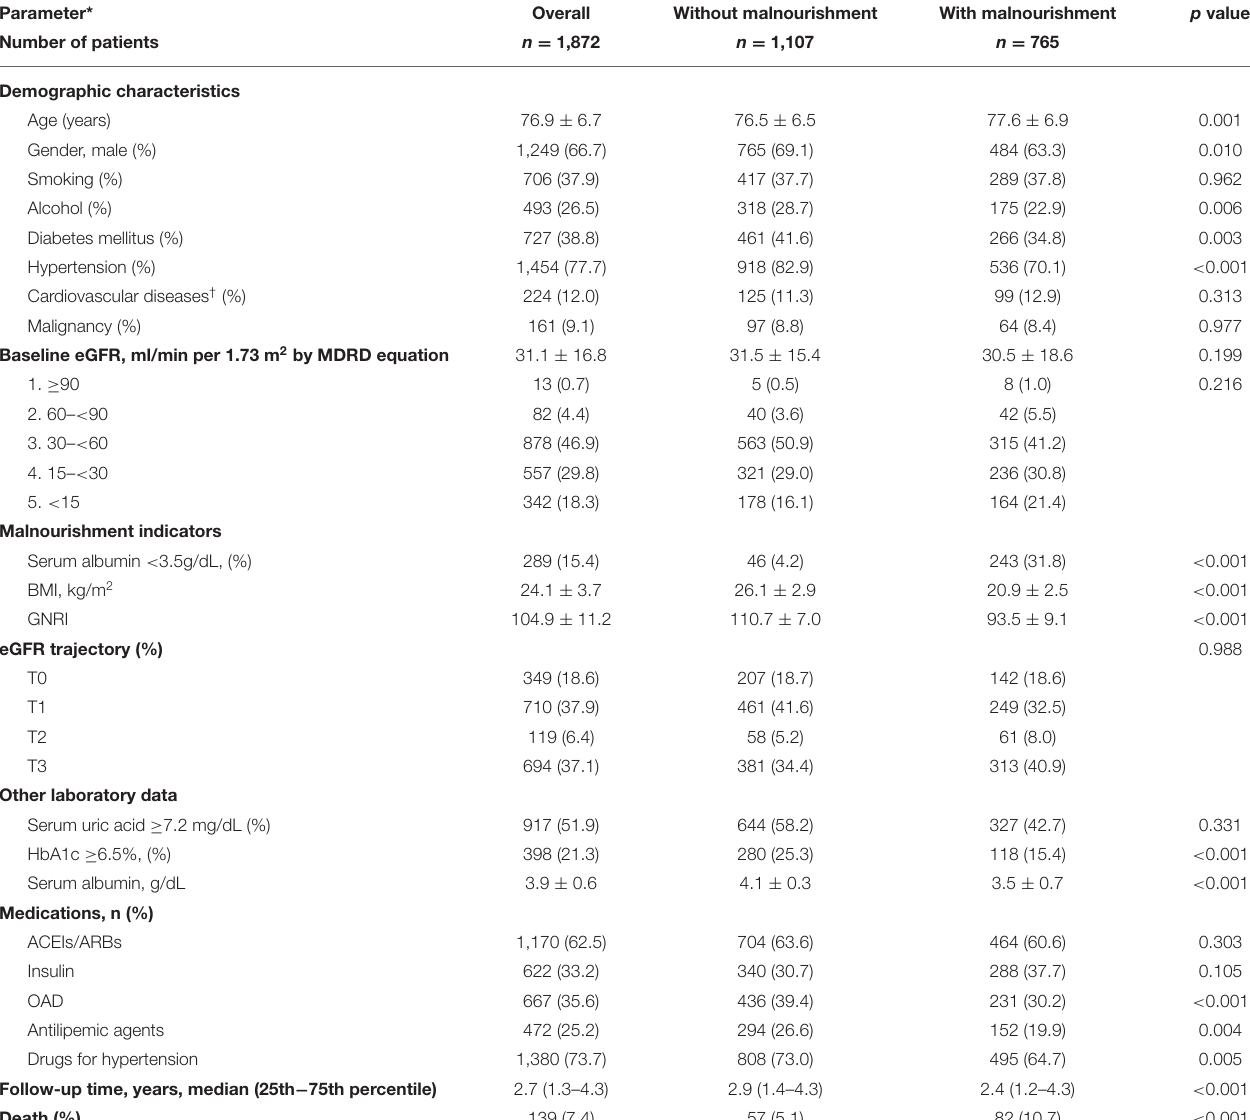
TABLE 3 | Demographic and clinical characteristics between older adults without and with malnourishment. Parameter* Overall Without malnourishment With